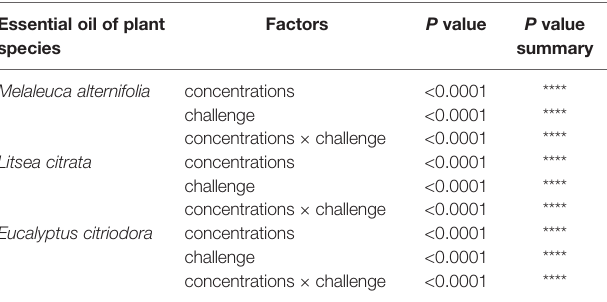
TABLE 3 | Two-way ANOVA showed main and interaction effects of indicated concentrations of essential oils and with or without Vibrio campbellii challenge on the survival of brine shrimp